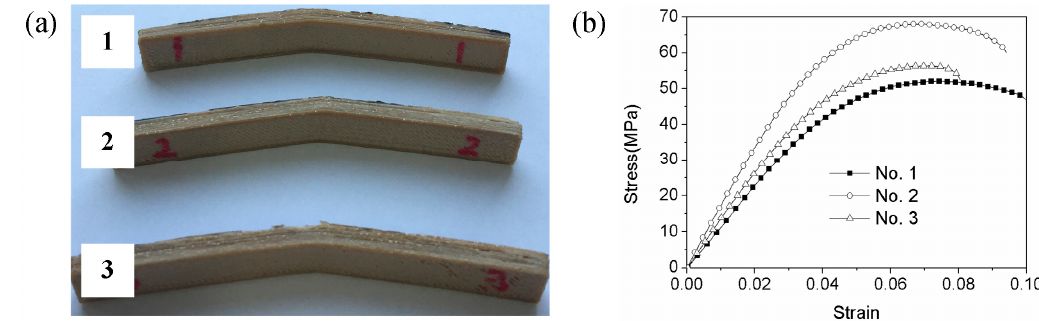
Figure 7. Bending test tests of PEEK FDM specimens. ( a ) Fractured bending specimens; ( b ) Bending stress-strain curves.